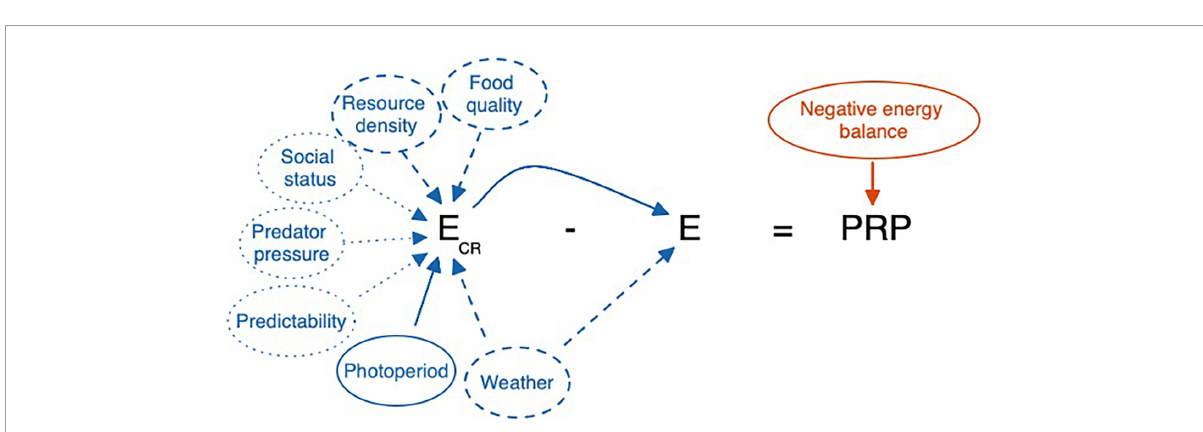
FIGURE8 Cues that may be used by a highly unresponsive individual, such as a short-season breeder in a highly unpredictable environment. Photoperiod being fixed in a natural environment, the animal may utilize extreme conditions of resource availability or weather as cues. However, in favoring the risk of a false negative error, some animals may rely on prolonged energy imbalance to trigger the emergency life history stage. Here photoperiod is a major reliable cue. Food quality and resource density are less reliable whereas social status, predator pressure, and overall predictability are least reliable as indicators of E cr . Note that here E = E e + E i . Variation in E e and E i can directly affect E and thus PRP. When E o occurs as well, this would increase E further and reduce PRP. E e , E i , and E o can all vary independently affecting E, and thus PRP, in different ways. Here we focus on E = E e + E i